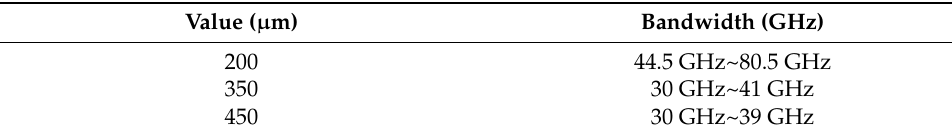
Figure 8. Reflection coefficient of L 3 variation. Table 3. The bandwidth of L 3 variation.